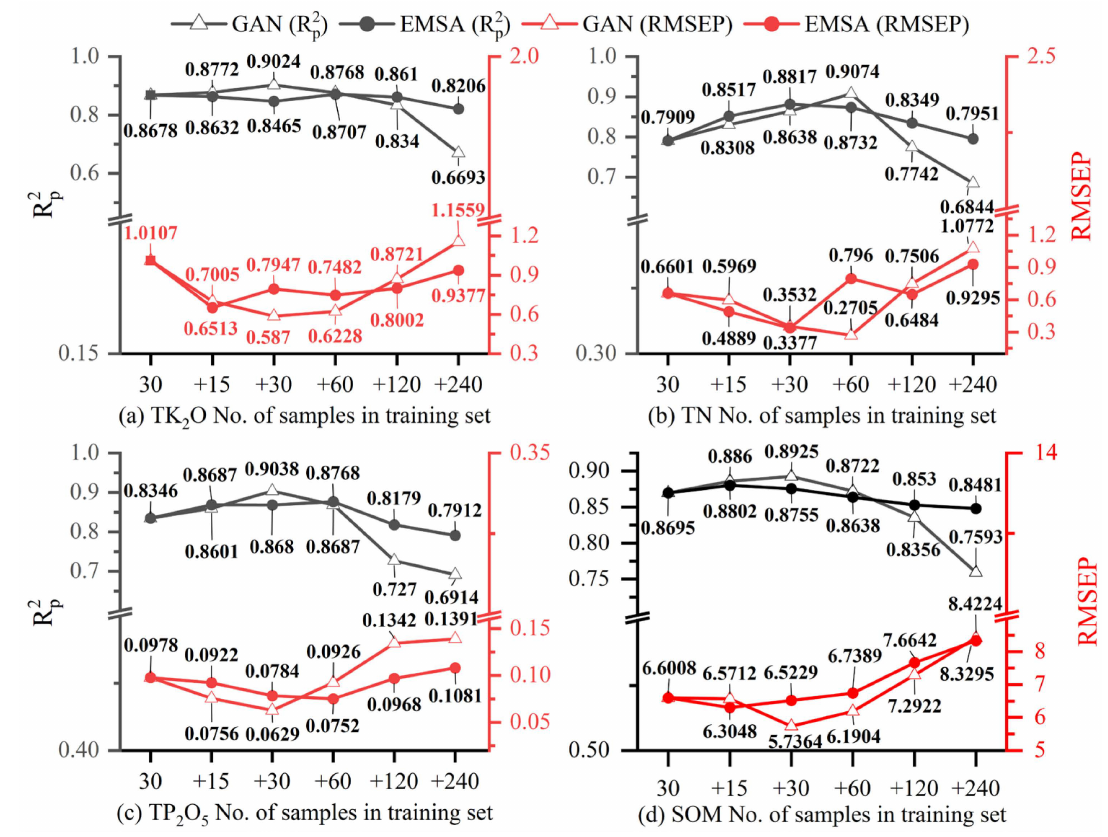
Figure 8. Variation in the prediction accuracy of CNN models with different augmentation methods and different numbers of training sets. Where 30 means that the training set is 30 real samples, and +15, +30, +60, +120, and +240 respectively means that 15, 30, 60, 120, and 240 GAN or EMSA samples are added into the 30 real